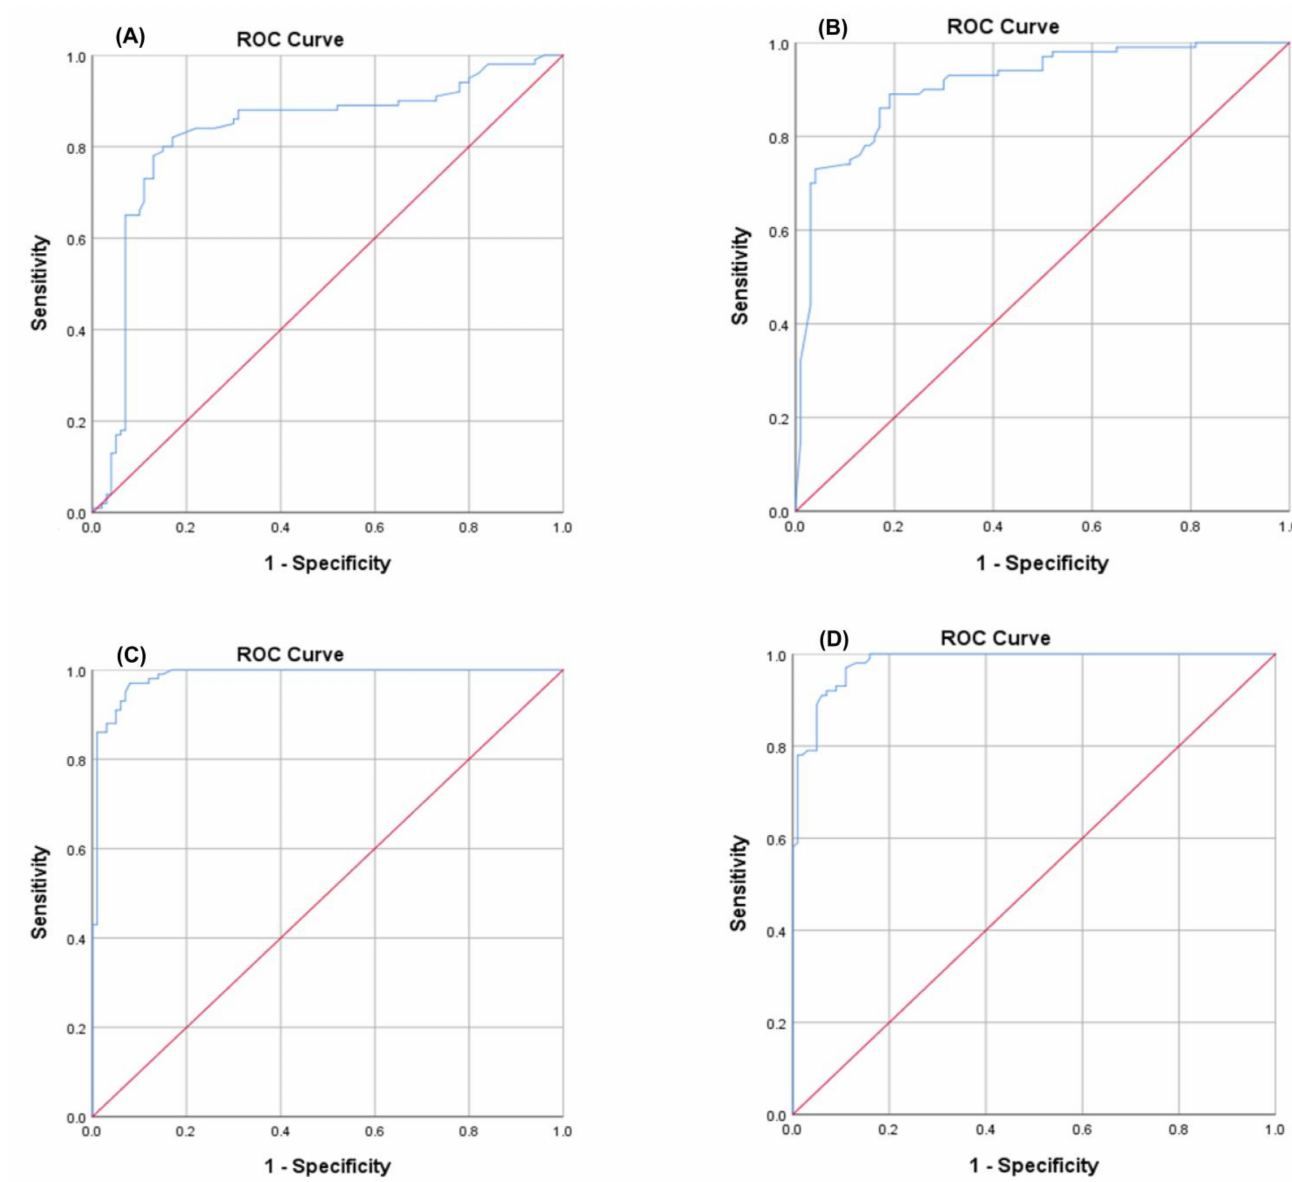
Figure 2. The receiver operator characteristic (ROC) curve presents the diagnostic accuracy of the IL11RA mRNA panel used to discriminate between SARS-CoV-2 and the control. ( A ) LncRNA RP11-773H22.4, ( B ) HSA-miRNA-4257, ( C ) IL11RA mRNA and ( D ) IL11RA